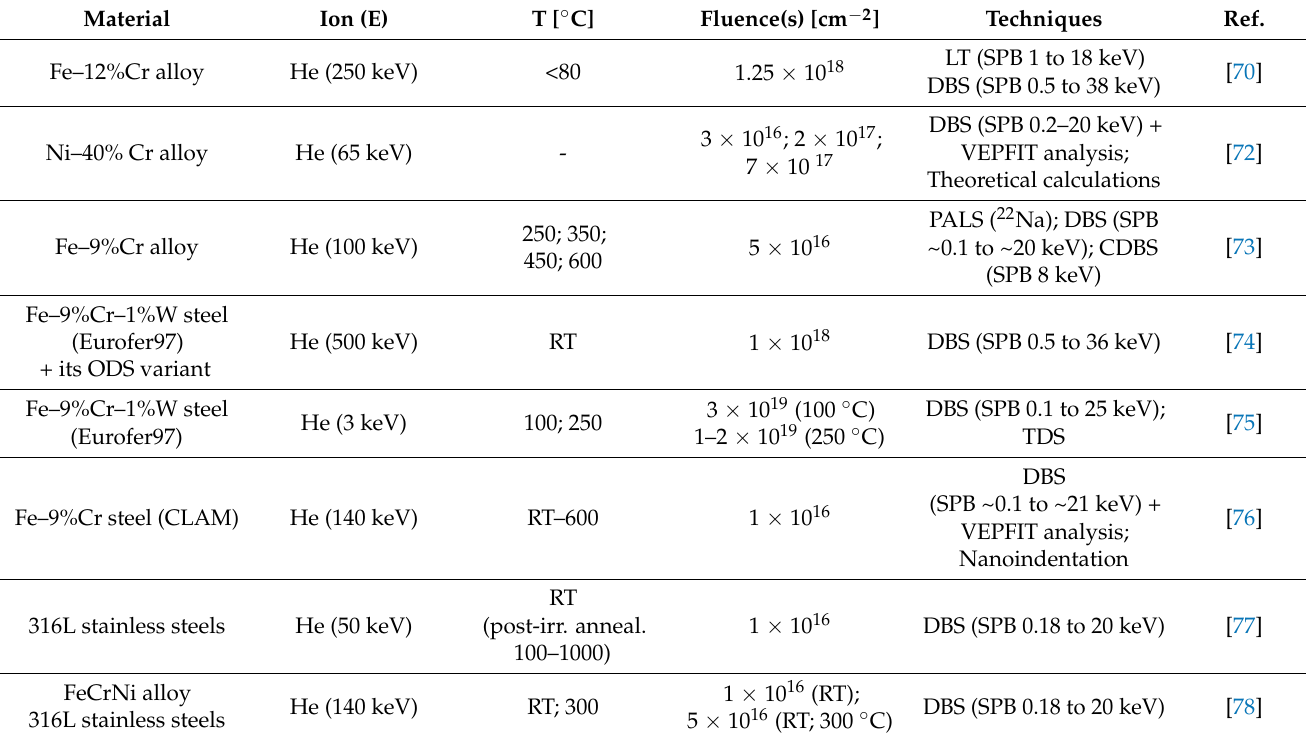
Table 3. Selected PAS studies published on helium irradiation of nuclear structural